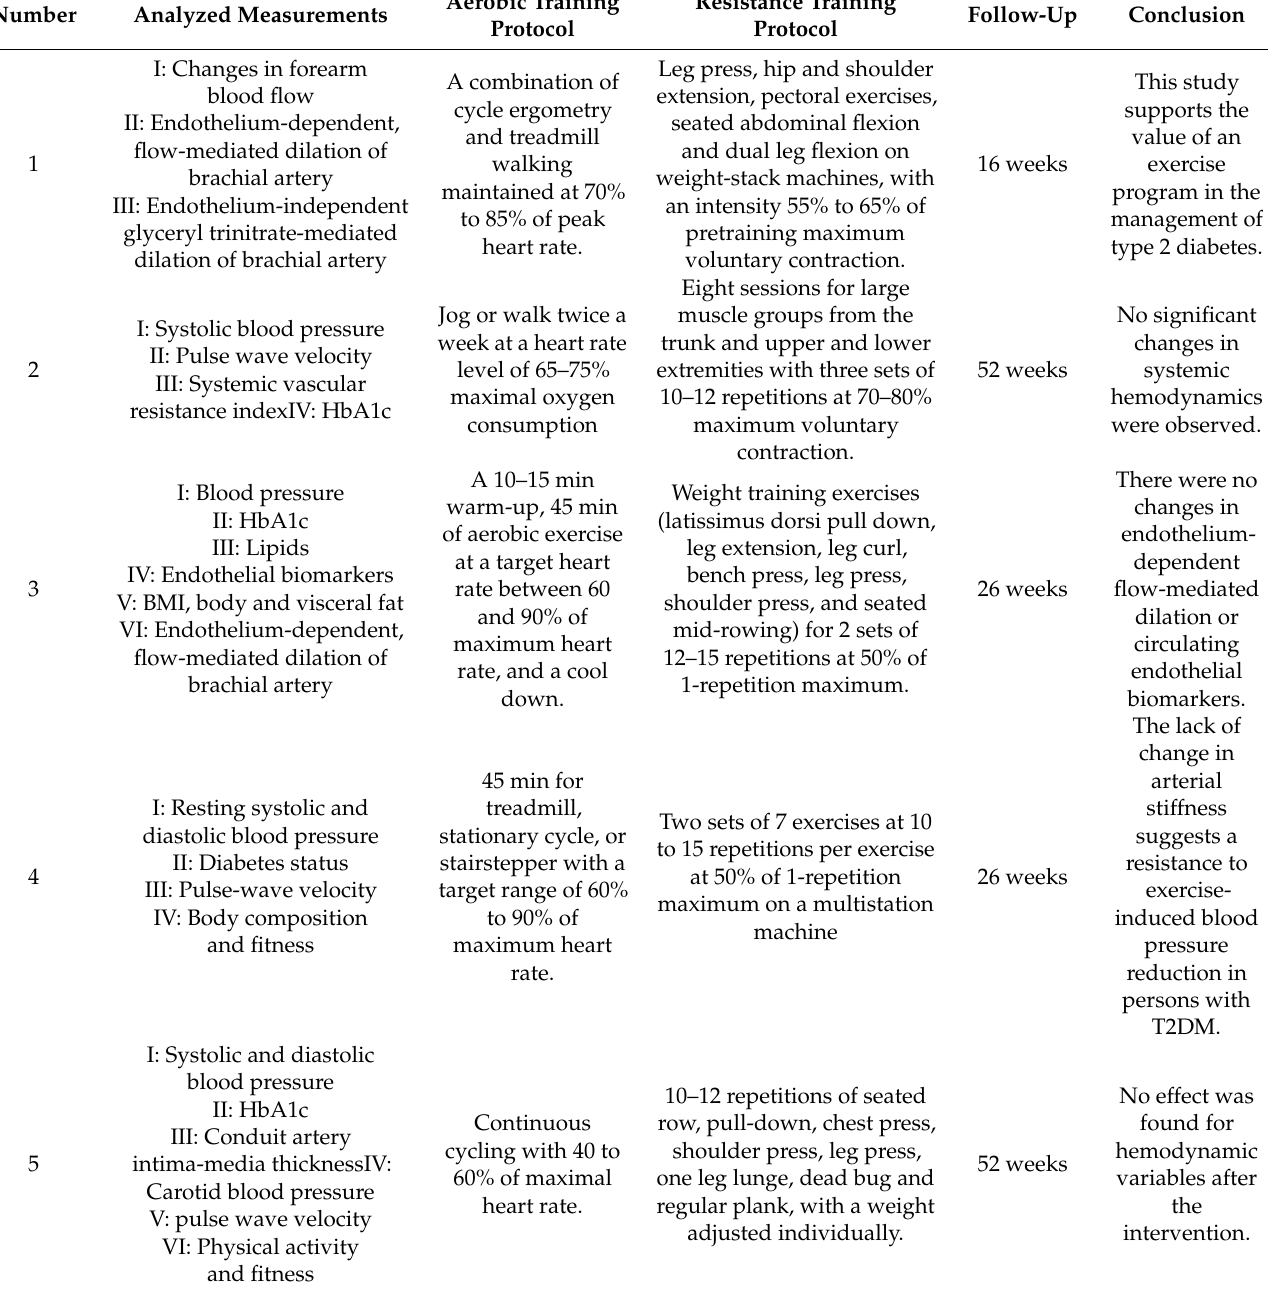
Table 2. Measurements, exercise protocols, follow-up duration, and